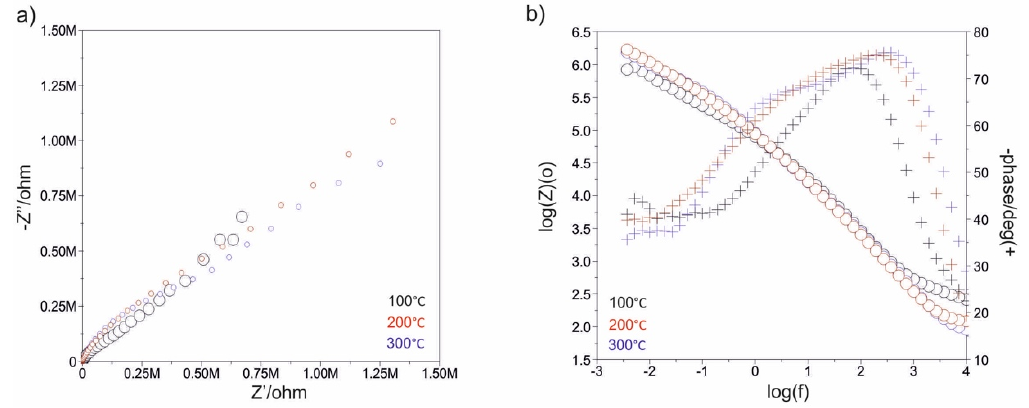
Figure 11. Impedance spectra determined for the ALD process in 500 cycles for the electropolished samples: ( a ) Nyquist diagram, ( b ) Bode diagram.